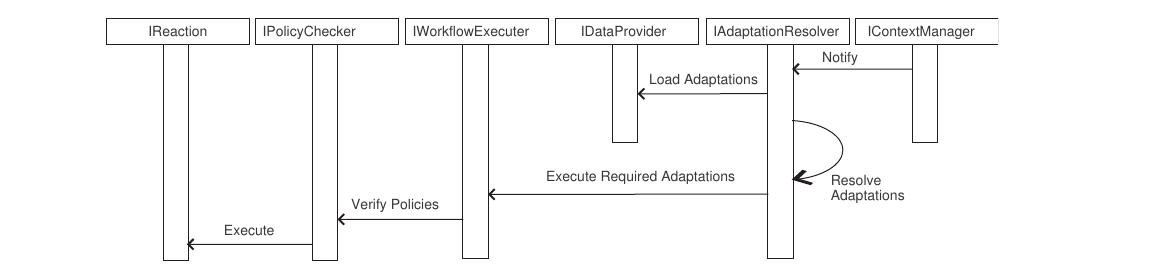
Figure 10. Sequence Diagram for the Resolving Component